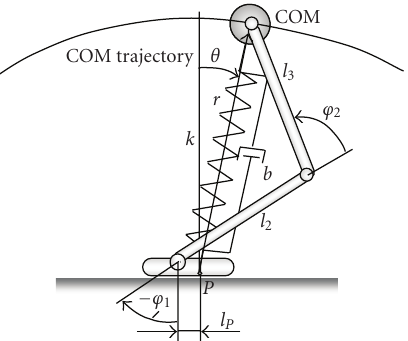
Figure 12: Calculation of ankle and knee joint angles using the COM trajectory of the mass-spring